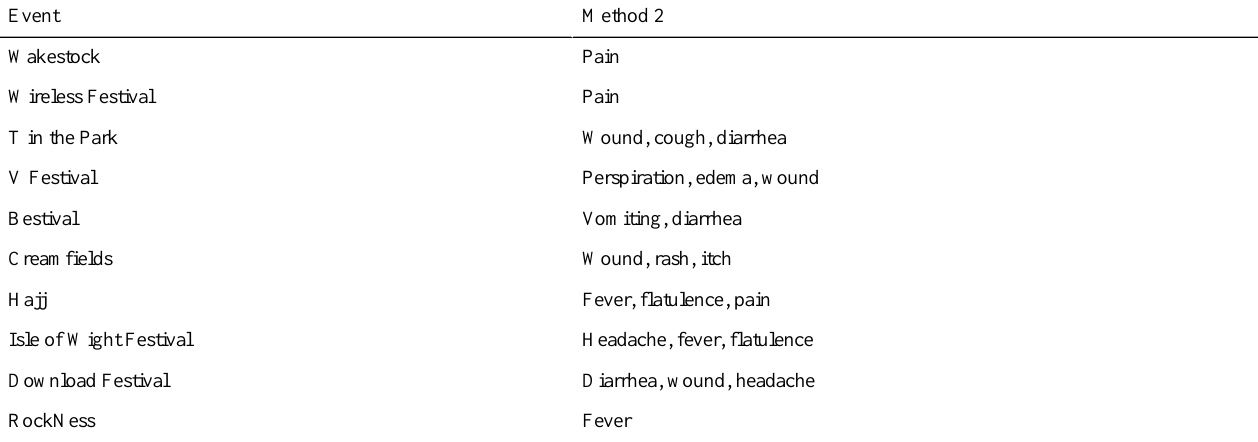
Table 5. Statistically significant symptoms a from Bing data for each event using Method